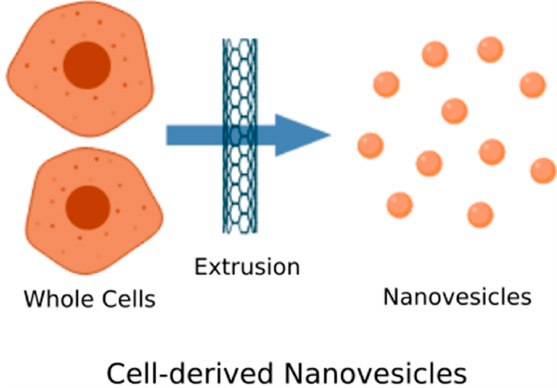
Figure 2 . Cell-derived nanovesicles. Whole cells are mechanically extruded to break the cell and create plasma membrane fragments. The fragments then self-assemble into nanovesicles that can retain intracellular molecules and surface makers.